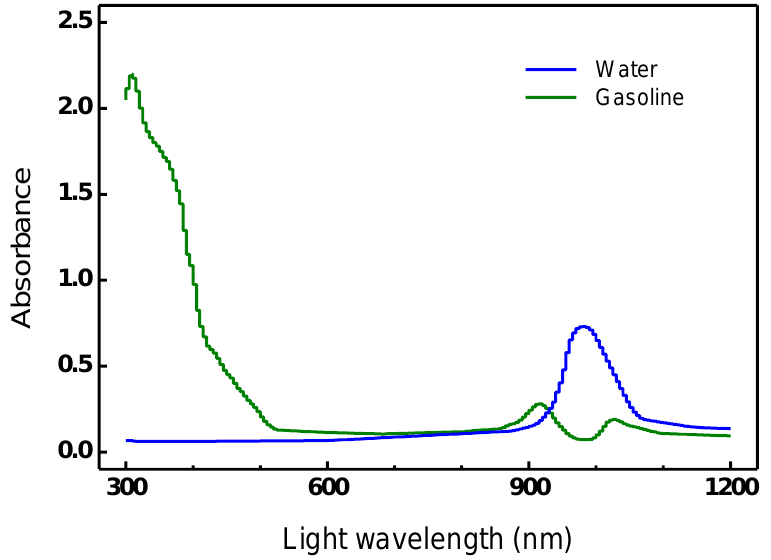
Figure 8. Spectral absorbance characteristics of water and